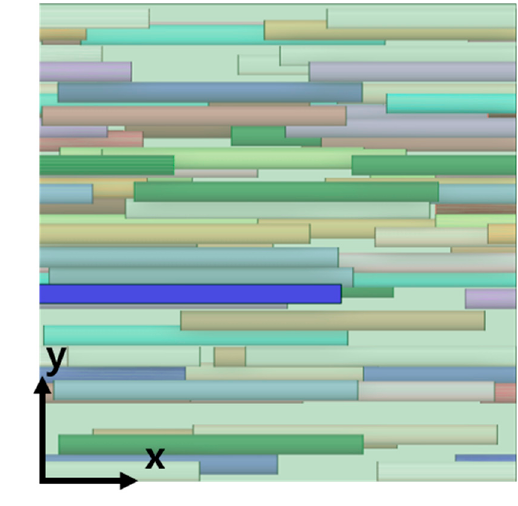
Figure 6. The x-y section of the finite element analysis model. ( a ) Aspect ratio 0.4, ( b ) Aspect ratio 15.